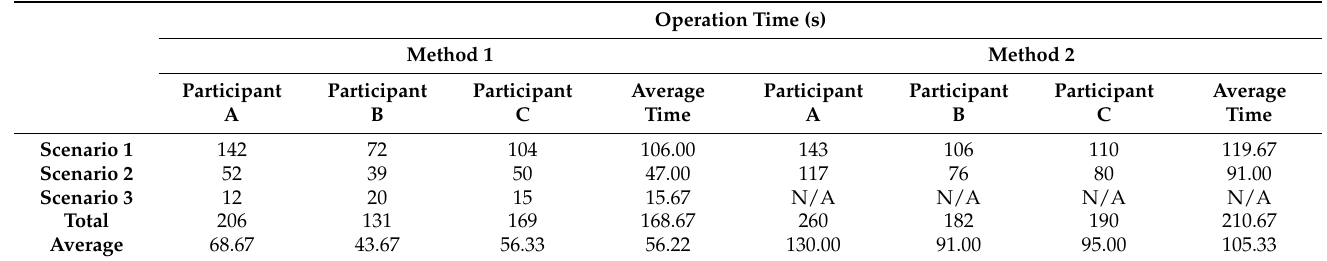
Table 4. Results of the feasibility test.